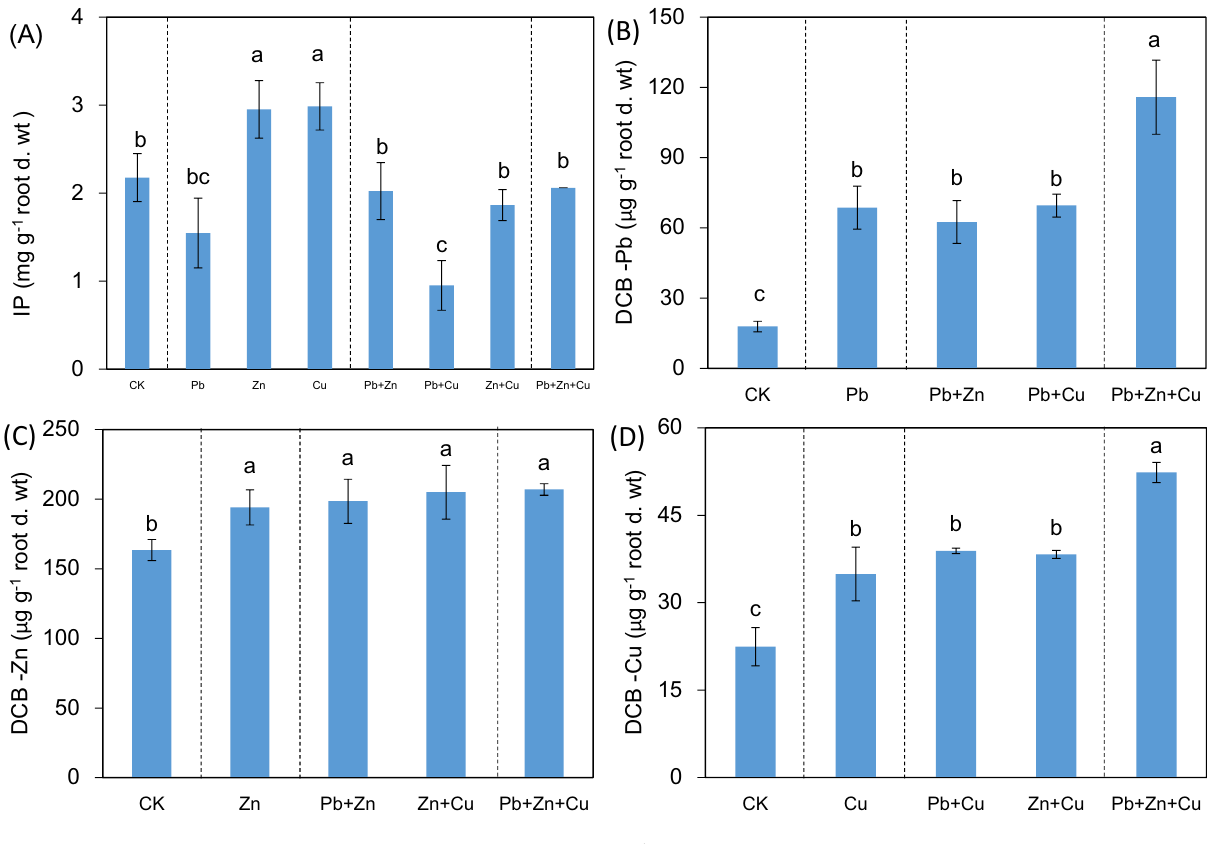
Figure 2. Iron plaque formation on root (mg g −1 root d. wt) and concentrations of DCB extractable Pb, Zn and Cu (μg g −1 root d. wt) for Kandelia obovata under individual and different combined stress of Pb, Zn, and Cu. Different lowercase letters indicate significant differences among treatments ( P <